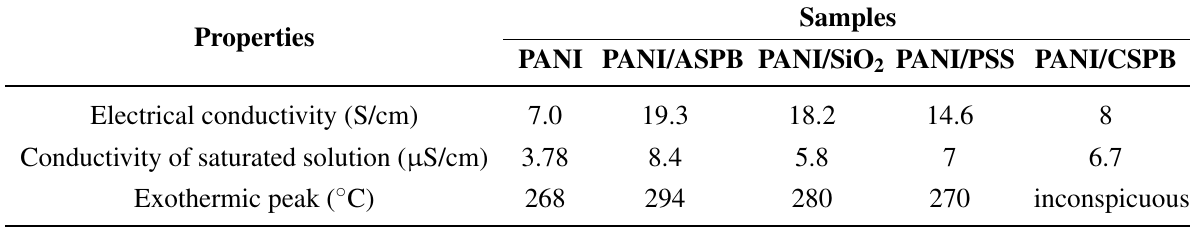
Table 1. Table 1.Effect of dopant species on the properties of